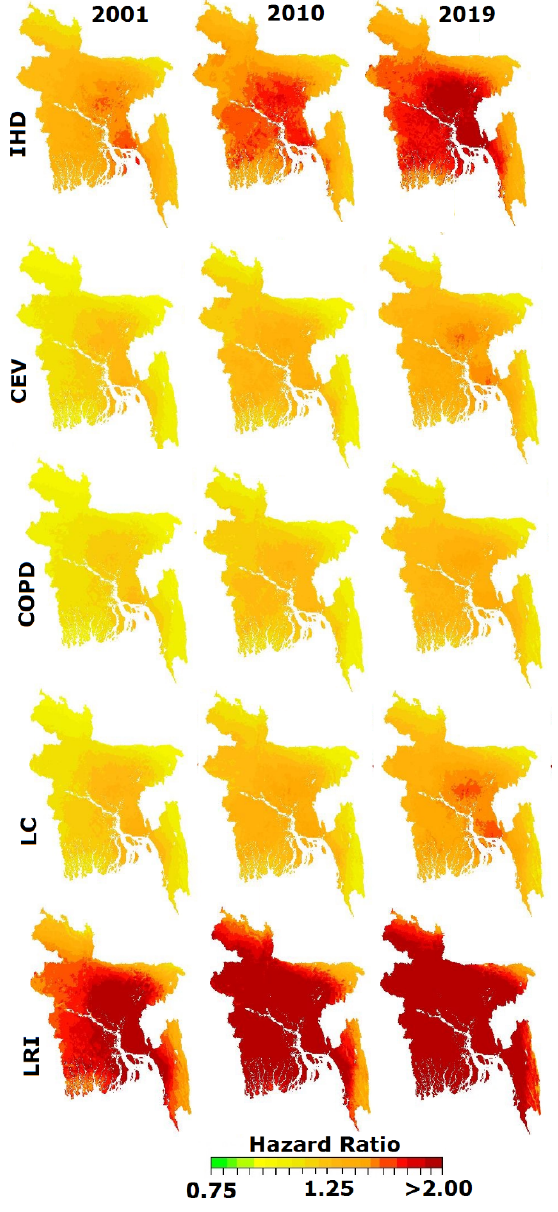
Figure 6 . Changes in hazard ratio of five diseases due to PM 2.5 over the period 2001–2019.